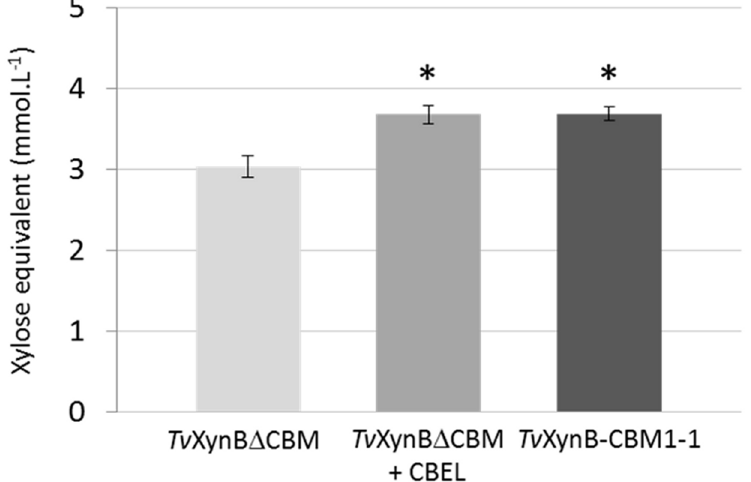
Fig 4. Complementation of Tv XynB with CBEL in Wheat straw hydrolysis. Tv XynB Δ CBM (0.1 mg enzyme/g substrate) was incubated with or without CBEL (10 mg.g -1 of wheat straw) at pH 3.0 and 40°C under agitation (1400 rpm) during 24h. Tv XynB-CBM1-1 without CBEL is shown as control. Experiments were conducted in triplicate. Asterisks indicate significant differences (p-value < 0.05, t -test compared to Tv XynB Δ CBM